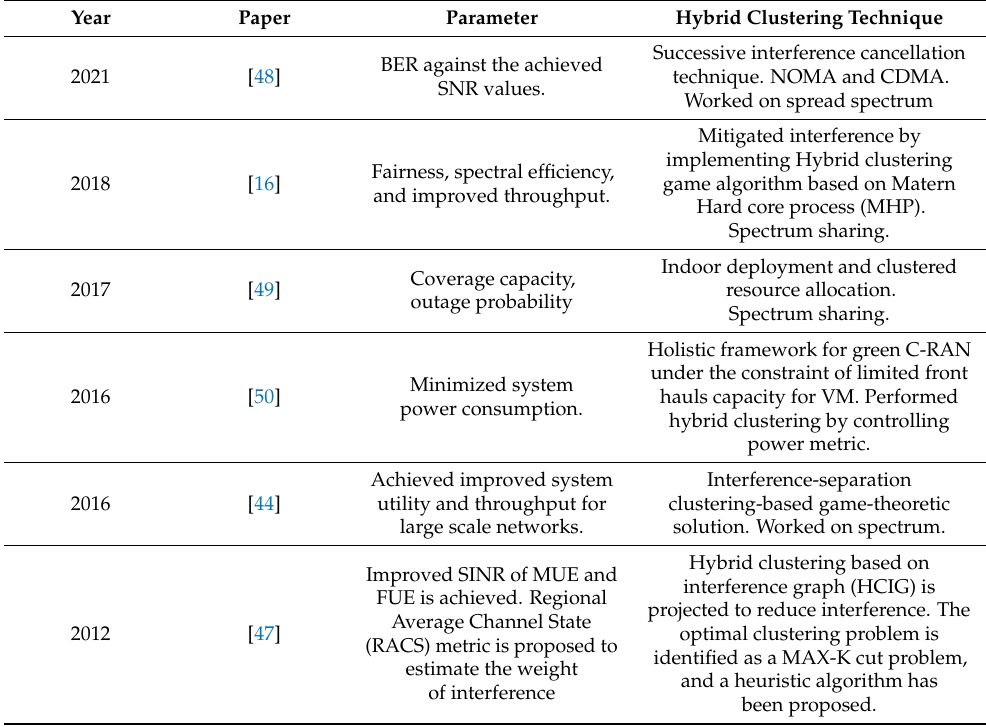
Table 2. Existing hybrid clustering